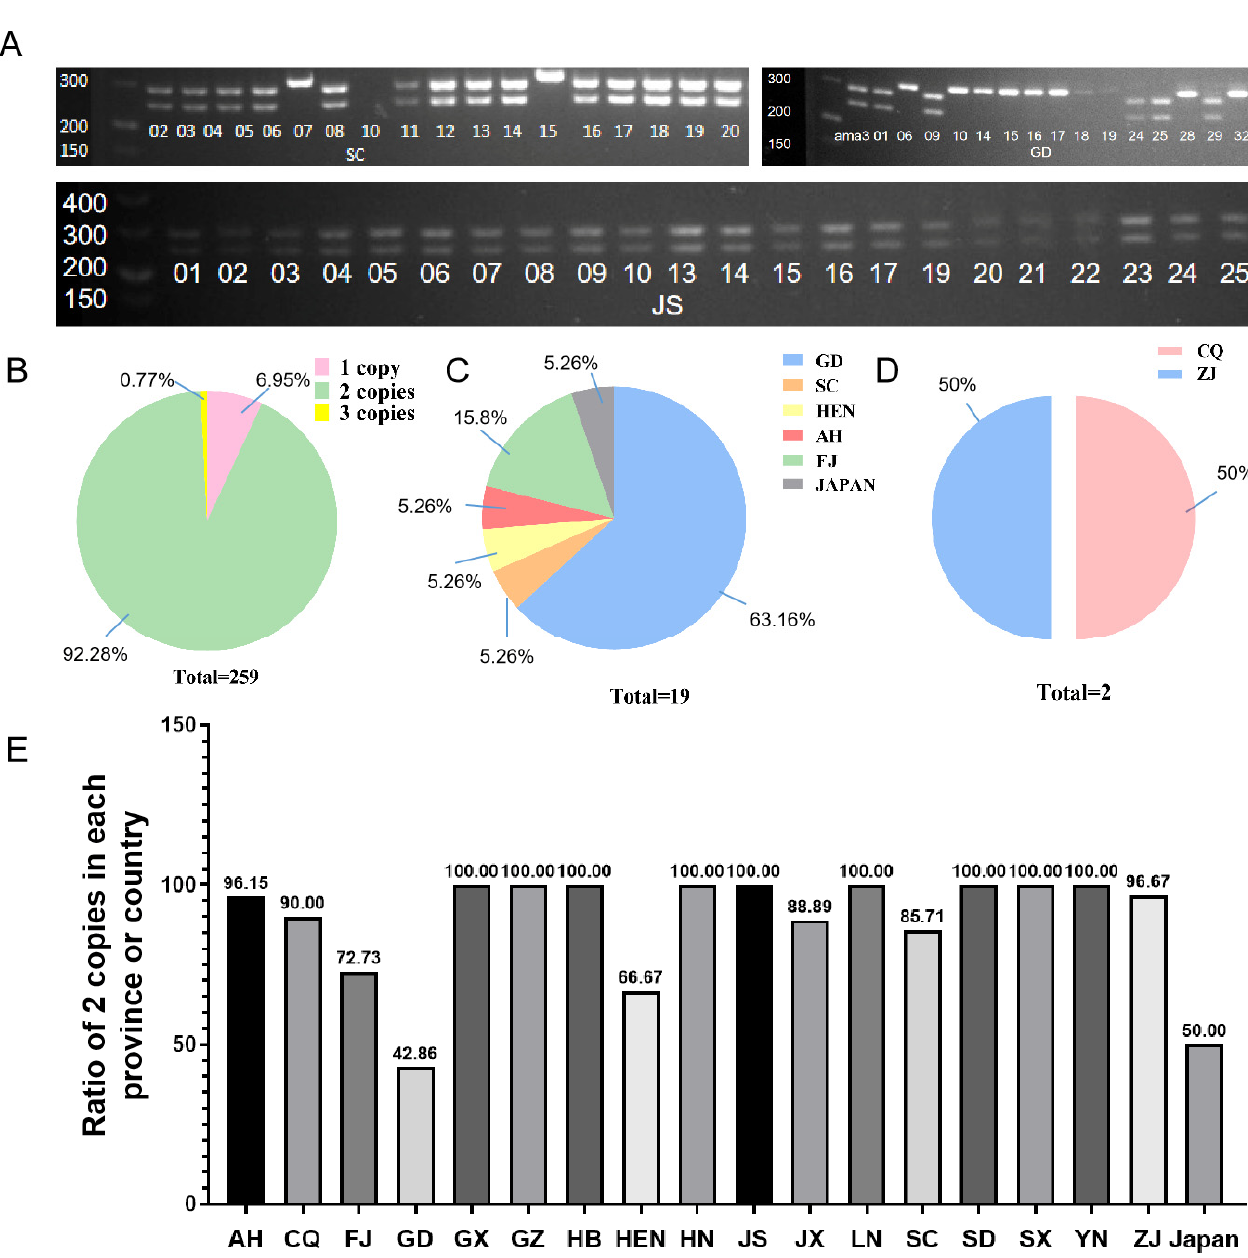
Figure 1. Distribution of copy number variations among different B. xylophilus strains. ( A ) Partial visualization result of CNV found in different nematode strains, SC means Sichuan province, GD means Guangdong, JS means Jiangsu, and the numbers indicate sample ID. ( B ) Percentage of different copies found in 259 B. xylophilus strains. ( C ) Geographical distributions of nematode strain with one copy, GD means Guangdong province, SC means Sichuan, HEN means Henan, AH means Anhui, and FJ means Fujian. ( D ) Geographical distributions of nematode strain with three copies, CQ means Chongqing, ZJ means Zhejiang. ( E ) Bar plot of the geographical distributions of B. xylophilus strains with two copies, AH means Anhui, CQ means Chongqing, FJ means Fujian, GD means Guangdong, GX means Guangxi, GZ means Guizhou, HB means Hubei, HEN means Henan, HN means Hunan, JS means Jiangsu, JX means Jiangxi, LN means Liaoning, SC means Sichuan, SD means Shandong, SX means Shaanxi, YN means Yunnan, ZJ means Zhejiang.